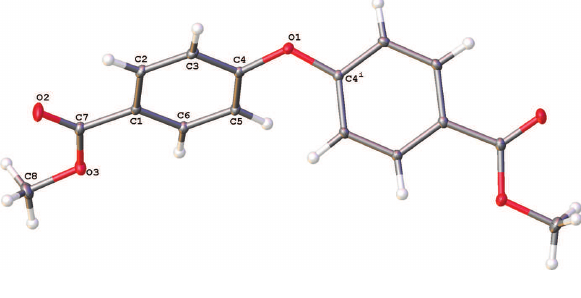
Table 1: Crystal collection and handling.